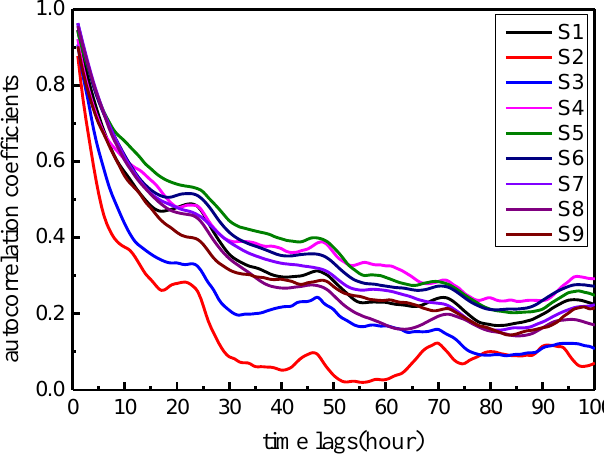
ffi cients at di ff erent time lags for di ff erent Figure 6. Comparison of the autocorrelation coefficients at different time lags for different stations. Figure 6. Comparison of the autocorrelation coe